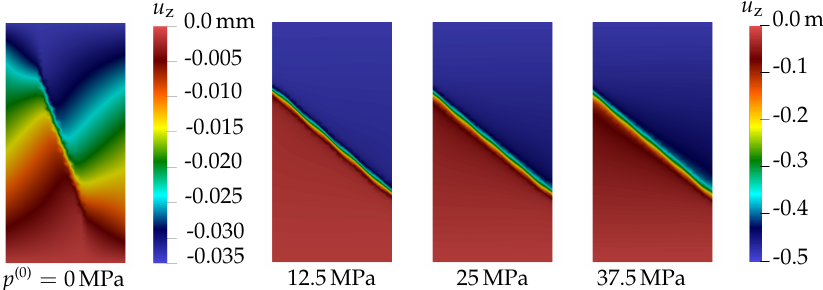
Figure 11. Triaxial compression tests: distribution of the vertical displacement u z in the symmetry plane for the four different levels of confining